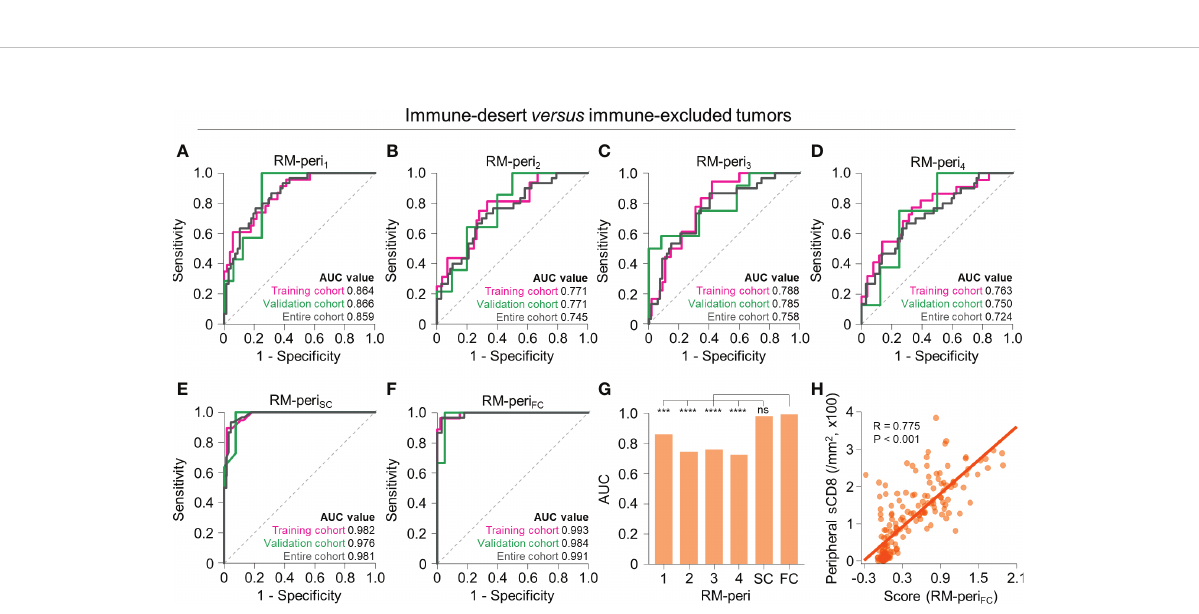
FIGURE 4 Radiomic models to predict immune-desert versus excluded immunophenotypes on the basis of radiomic features from the peripheral tumor. (A – F) The receiver operating characteristic curves of RM-peri 1 (A) , RM-peri 2 (B) , RM-peri 3 (C) , RM-peri 4 (D) , RM-peri SC (E) , and RM-peri FC (F) for discriminating between immune-desert and excluded tumors in the training ( pink ), validation ( green ), and entire cohorts ( gray ). (G) The comparison of the AUC values of the six radiomic models derived from the peripheral tumor. (H) The correlation between the radiomic score obtained from RM-peri SC and the peripheral stromal CD8 + T cell density. Statistical analyses were performed using Delong ’ s test (G) and Pearson ’ s correlation test (H) . *** P < 0.001, **** P < 0.0001. RM, radiomic model; AUC, area under the receiver operating characteristic curve; ns, not signi fi cant; sCD8, stromal CD8 + T cells.